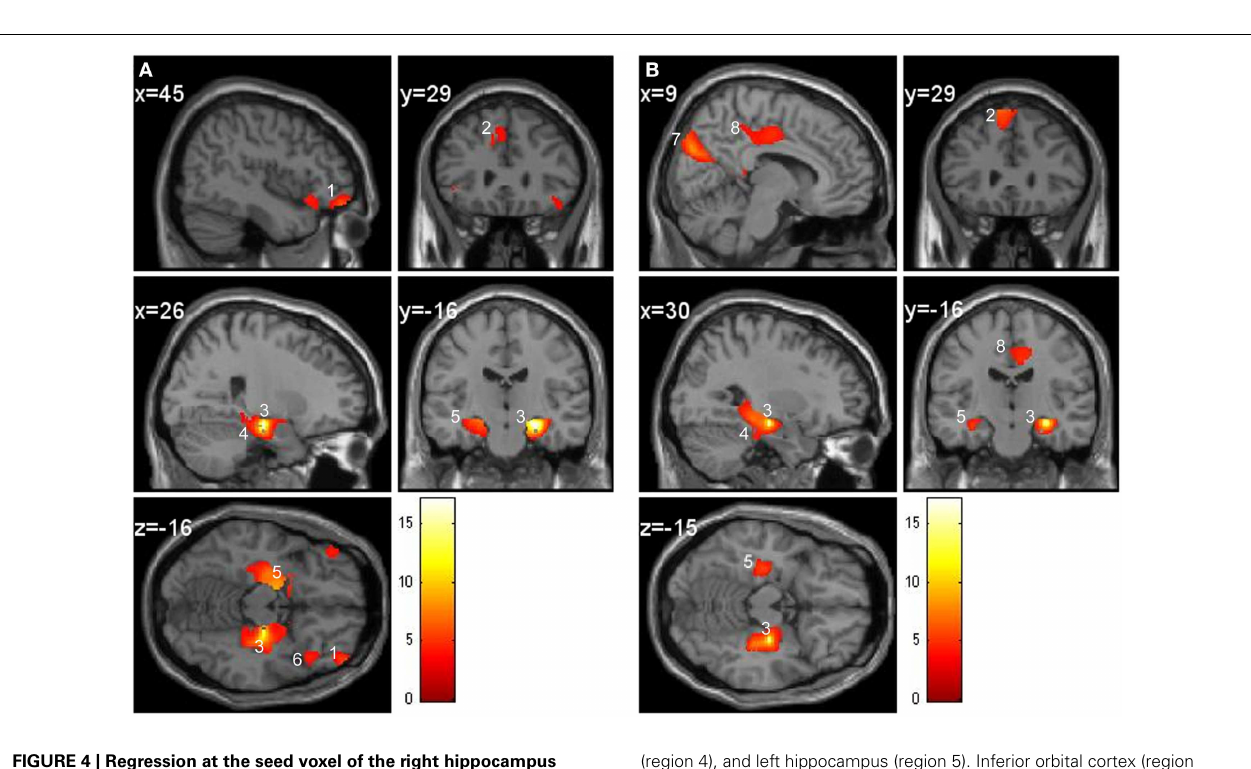
FIGURE 4 | Regression at the seed voxel of the right hippocampus (24, − 21, − 15) in controls (A) and in patients (B) .The t maps are superimposed onto an anatomical brain and displayed in the sagittal, coronal, and horizontal planes. (A) Right hippocampus (region 3) in controls covaries significantly with the frontal middle orbital cortex (region 1), superior medial gyrus (region 2), right parahippocampal cortex